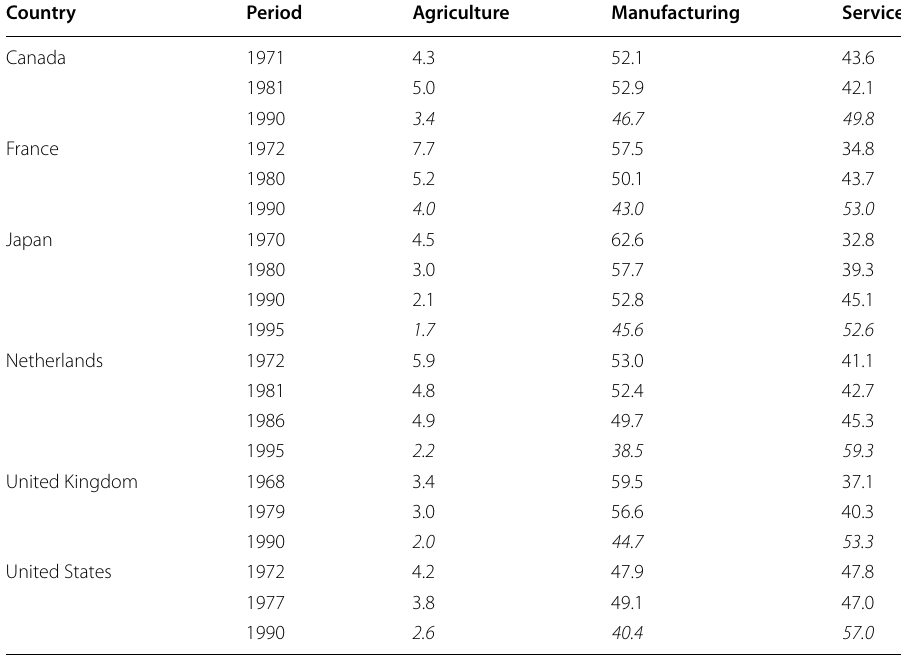
Table 10 Sectoral shares of production in developed countries (annual rate, unit: